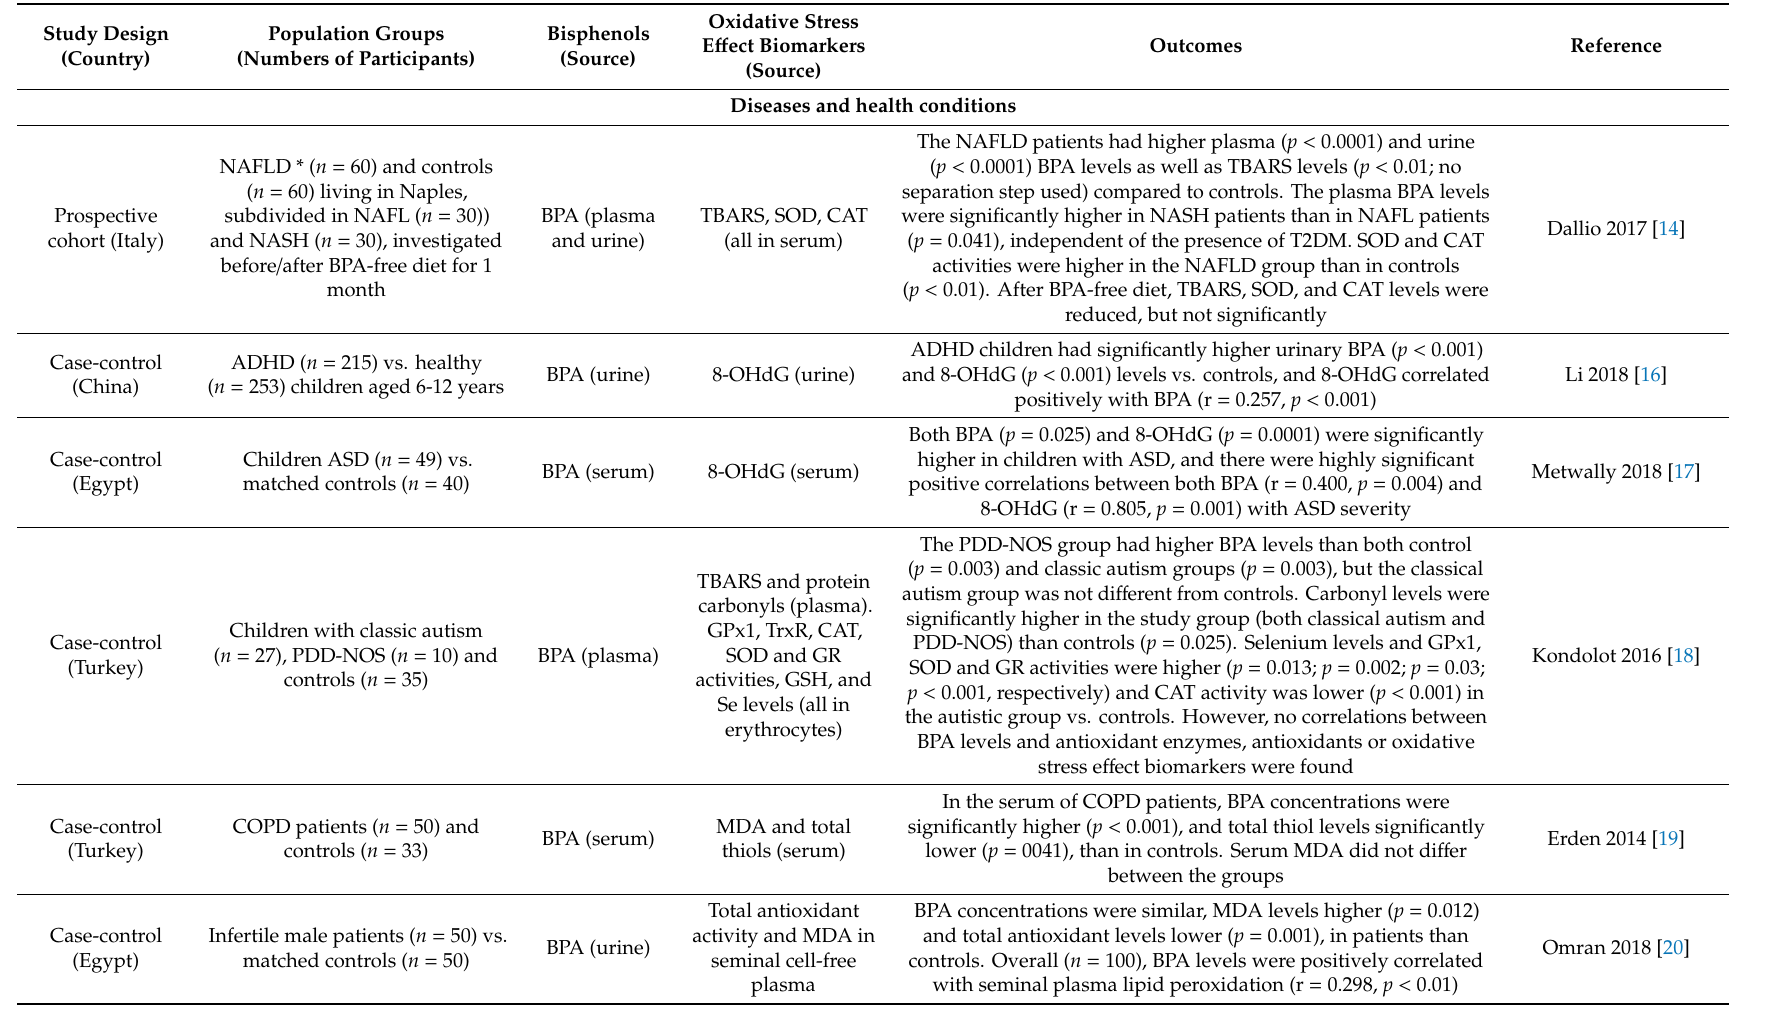
Table 1. Human studies on bisphenols and biomarkers of oxidative stress during years